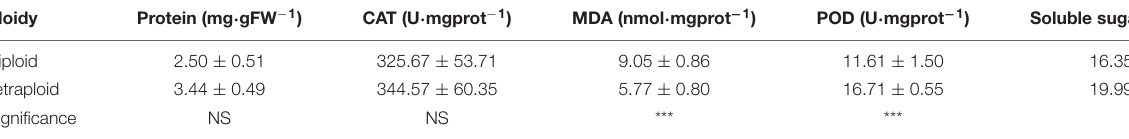
TABLE 7 | Physiological parameters of diploid and tetraploid Eucalyptus urophylla .